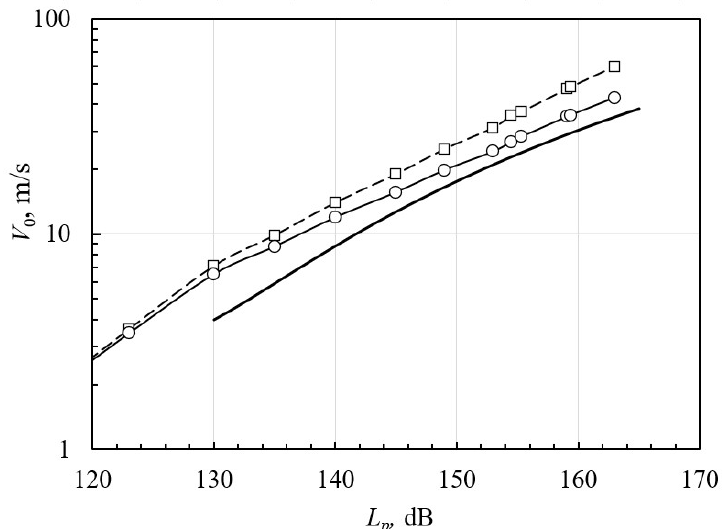
Figure 6. Dependence of the oscillation velocity in the resonator neck on SPL obtained by the two- microphone method (-□-), three-microphone method (- ○ -) and measurements with a Pitot tube ( ─ ). tube